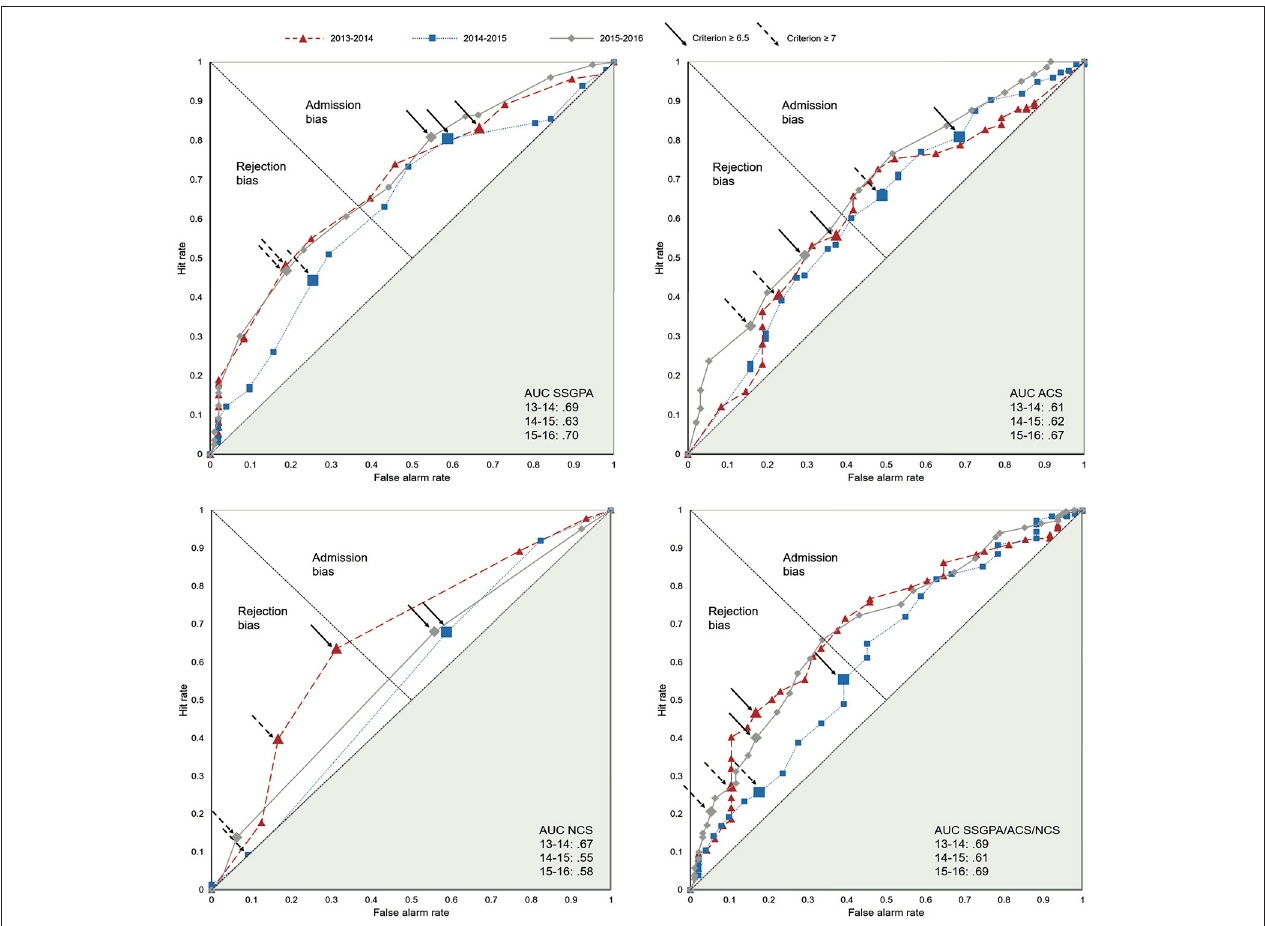
FIGURE 4 | Receiver Operating Characteristic Curves (ROC-curves) for three consecutive cohorts for Secondary School Grade Point Average (SSGPA), Admission test Cognitive Score (ACS), Non-Cognitive Score (NCS), and the unweighted mean of SSGPA, ACS, and NCS (SSGPA/ACS/NCS). The diagonal from the upper left corner to the middle of each ROC-space represents a neutral criterion and thus equal proportions of misses and false alarms. The solid arrows point to the enlarged data point for each cohort corresponding to criterion ≥ 6.5 and the dashed arrows point to the enlarged data point for each cohort corresponding to criterion ≥